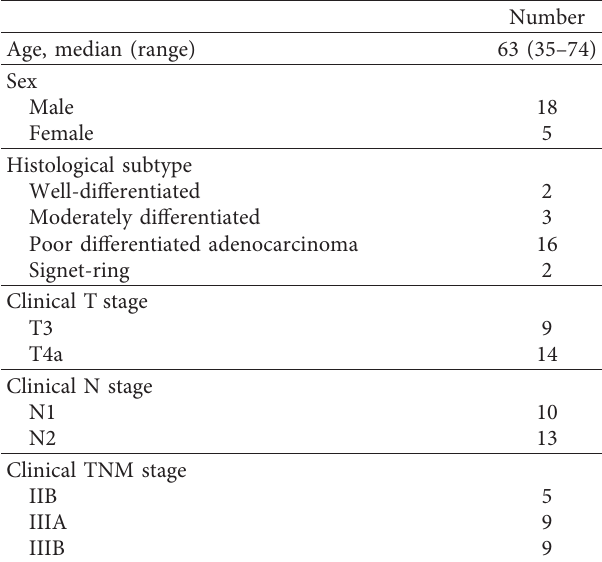
Table 1: Patient demographics ( n � 23).